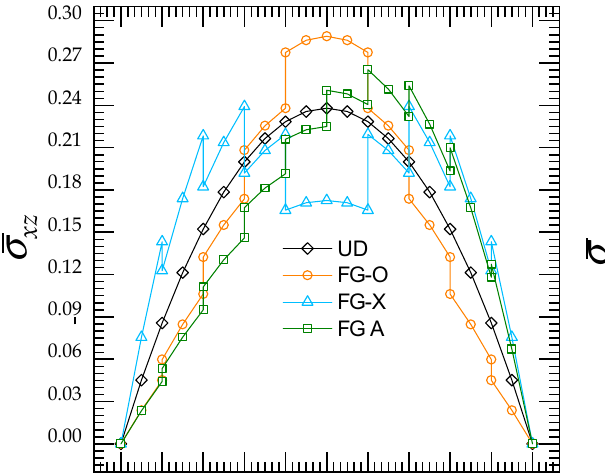
Figure 17. Various dimensionless stresses through simply supported square GRNC plate thickness with different GPLs reinforcement patterns ( g (cid:2891)(cid:2900)(cid:2896)∗ = 1%, 𝑎 ℎ⁄ = 5, 𝑎 (cid:2891)(cid:2900)(cid:2896) = 𝑏 (cid:2891)(cid:2900)(cid:2896) = 10 (cid:2870) nm, 𝑎 (cid:2891)(cid:2900)(cid:2896) = 0.7 nm ).